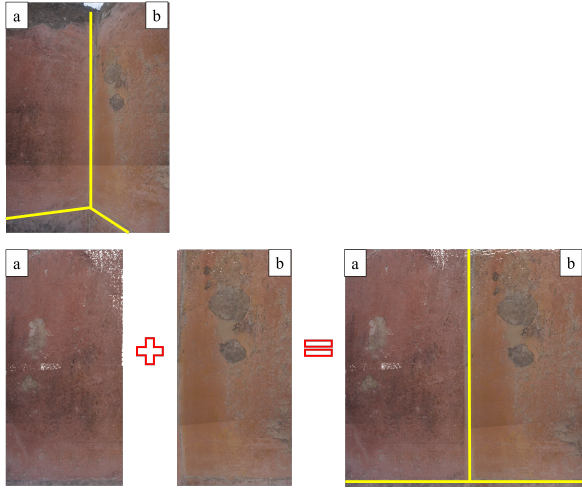
Figure 6. Perspective view and corresponding orthophotos of two adjacent walls.